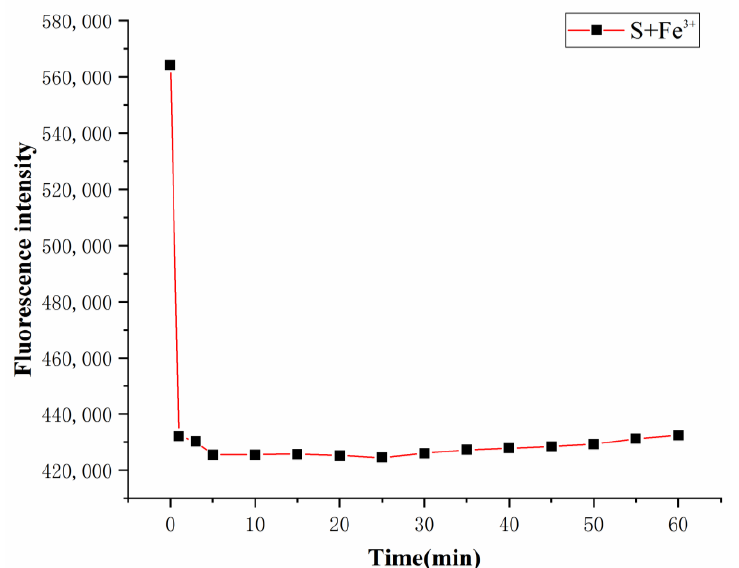
Figure 6. Time course of the fluorescence response of probe S (20.0 μM) in the presence of Fe 3+ (1 × 10 −2 M) at room temperature.